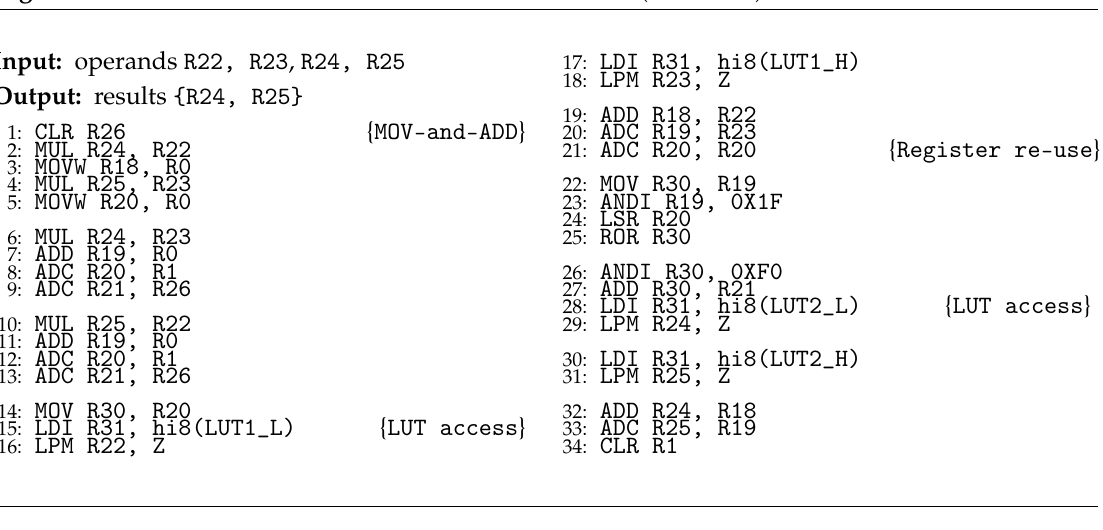
Algorithm 2 LUT-based modular reduction in source code (mod